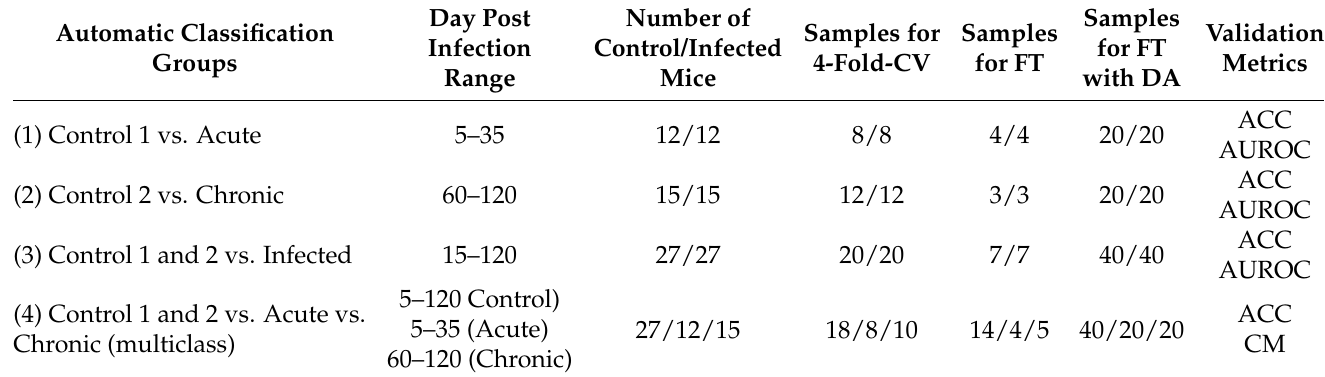
Table 1. Groups, data proportion, and validation metrics for automatic